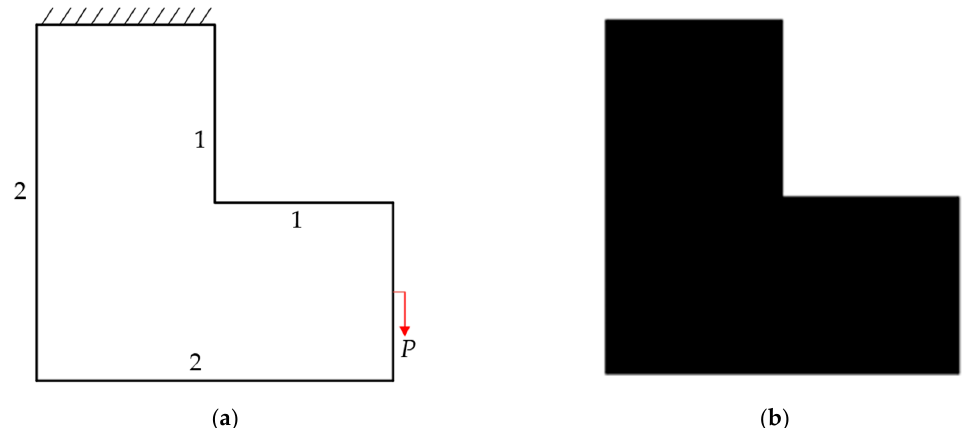
Figure 3. Optimum design problem of L-shaped beam, ( a ) design domain and boundary conditions; ( b ) initial shape.